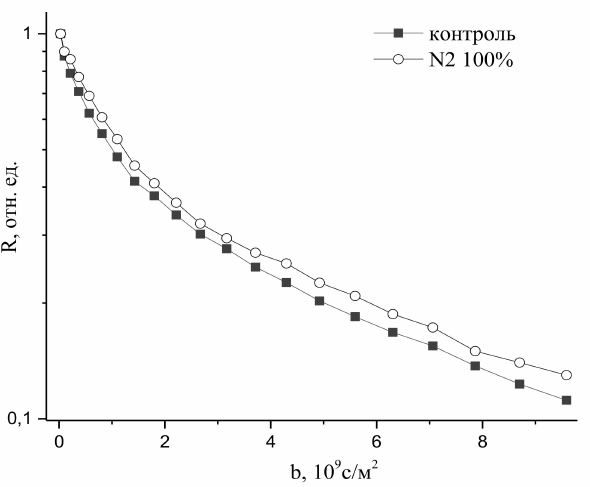
Figure 24. Diffusion decays of water magnetization in cells of intact corn roots in control and 2 h after increasing the nitrogen concentration N 2 in the leaf zone up to 100% under normobaric conditions in the atmosphere ( b = γ 2 δ 2 g 2 t d ) [96].